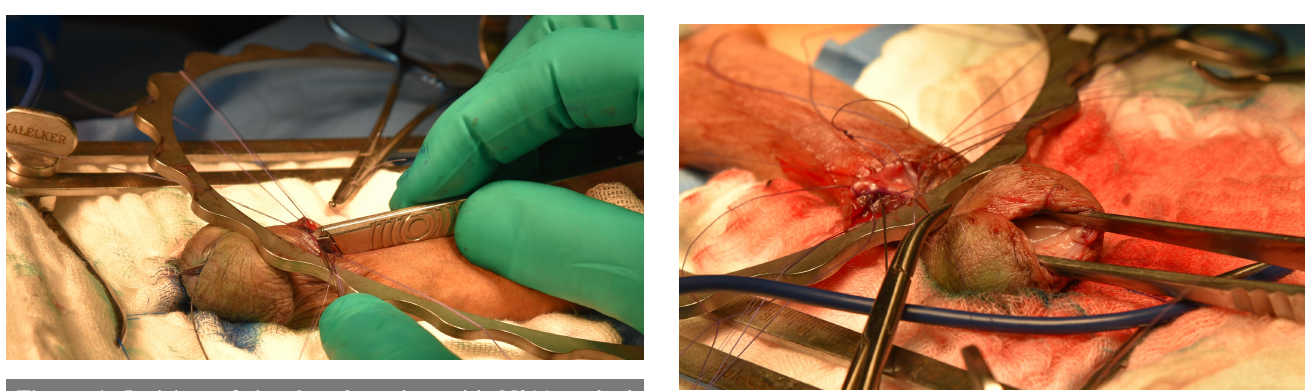
Figure 4. Incision of the dorsal urethra with N ° 11 scalpel through the keyhole incision. The same is done in the opposite direction from the meatus to the distal urethra. A Debakey forceps is used to spread the glans or the distal urethral opening to guide the incisions. The Joshi-Kulkarni retractor and Dennis Brown ring are used for optimal exposure.